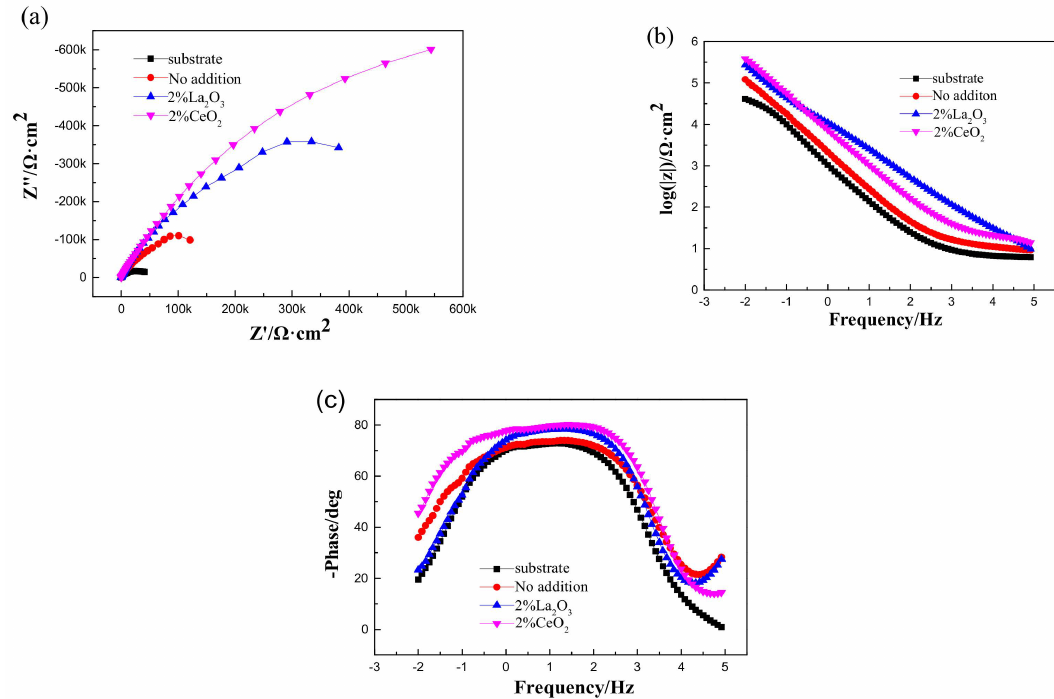
Figure 7. Electrochemical impedance spectroscopy (EIS) of 316L stainless steel before and after rare earth oxide-modified laser cladding in 3.5 wt % NaCl solution: ( a ) Nyquist diagram; ( b , c ) Bode diagram.